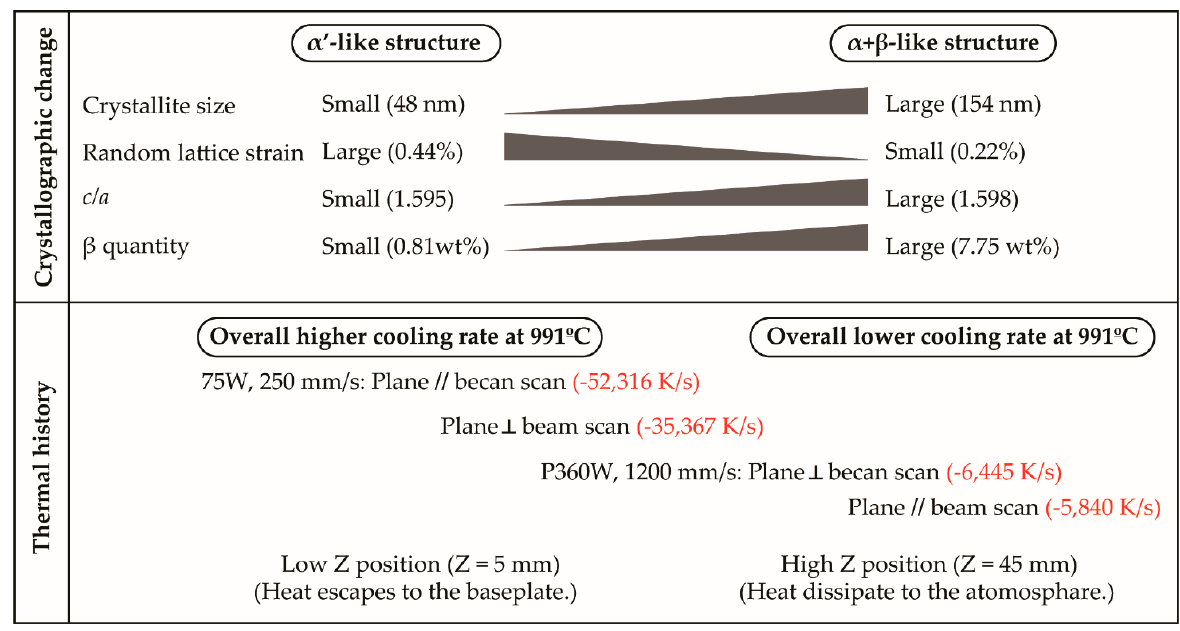
Figure 13. L-PBF process parameters and α ’ → α + β phase evolution.